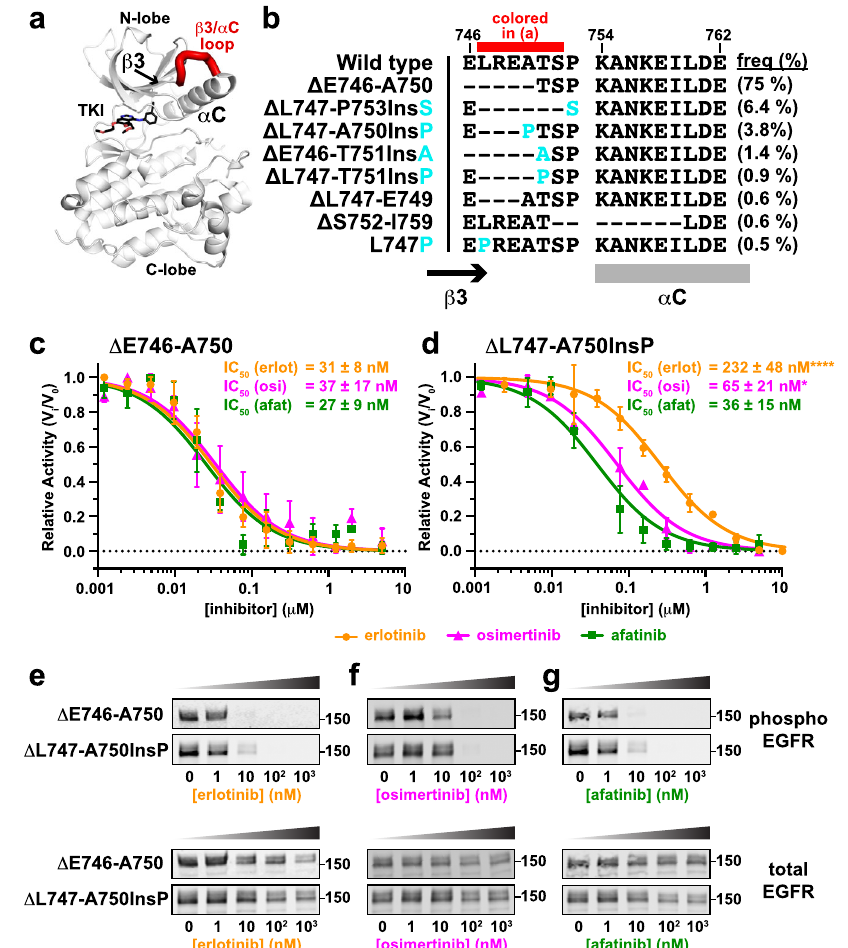
Fig. 1 | Differential inhibitor sensitivity of puri fi ed EGFR TKDs. a Crystal struc- ture of the EGFR kinase domain bound to erlotinib (PDB ID: 1M17 40 ), showing the locationofthe β 3- α Cloop(red)encodedwithin EGFR exon19.Erlotinibisshownin black sticks. b Sequences of the β 3/ α C region of wild type EGFR and each exon 19 variantthatcouldbestudiedhere(seeSupplementaryFig.1),withdeletedresidues indicated by dashes and inserted non-native amino acids highlighted in cyan. The reported frequency of each exon 19 variant in the COSMIC database 3 — as a per- centage of all exon 19 mutations seen in NSCLC patients — is shown in parenthesis.